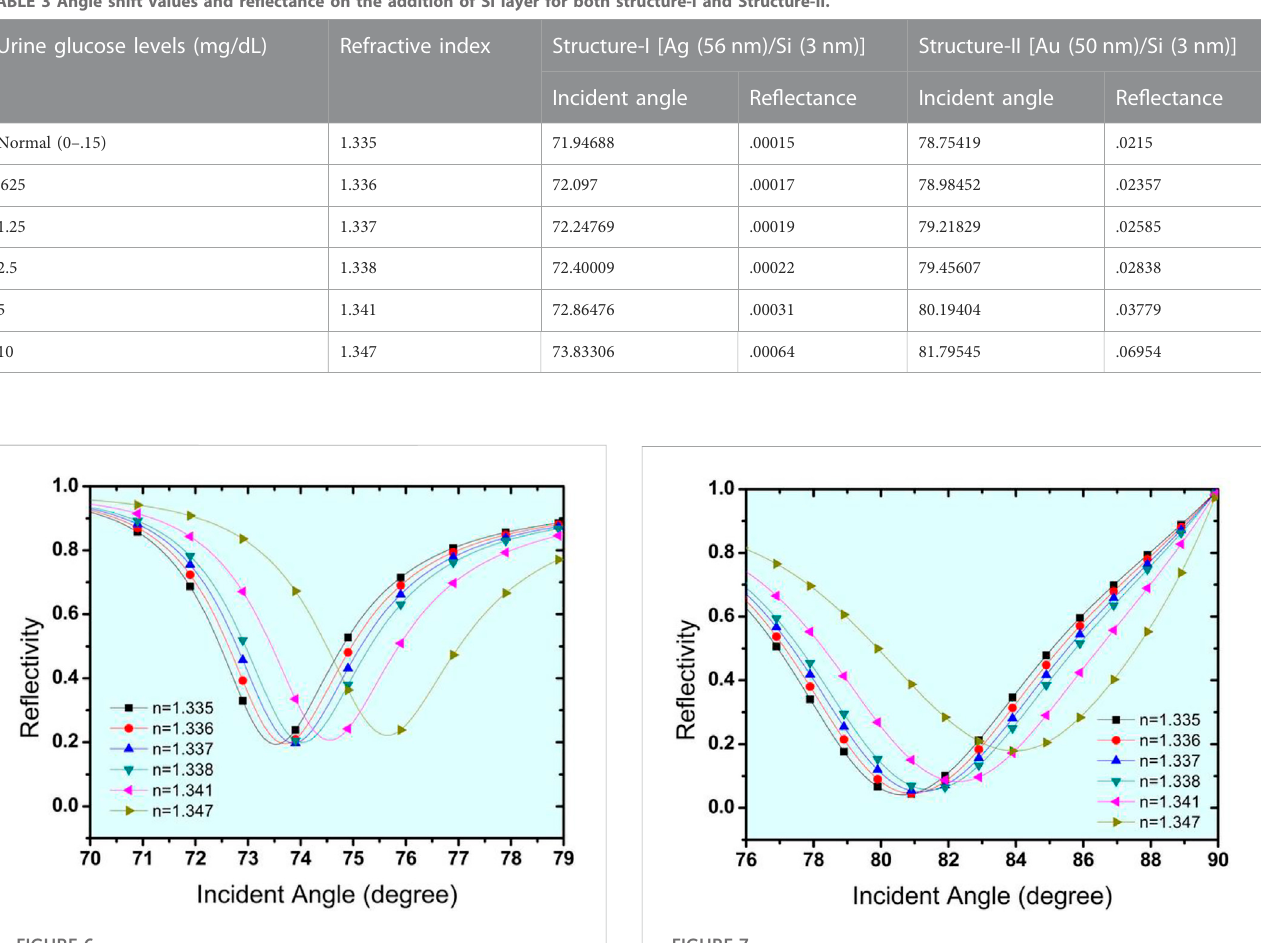
FIGURE 6 Re fl ectivity curve with respect to change in incident angle for the detection of urine glucose in bio-sample for Structure-I (Prism/Ag/Si/ WS 2 /Bio-sample) with effect of WS 2 nanomaterial.